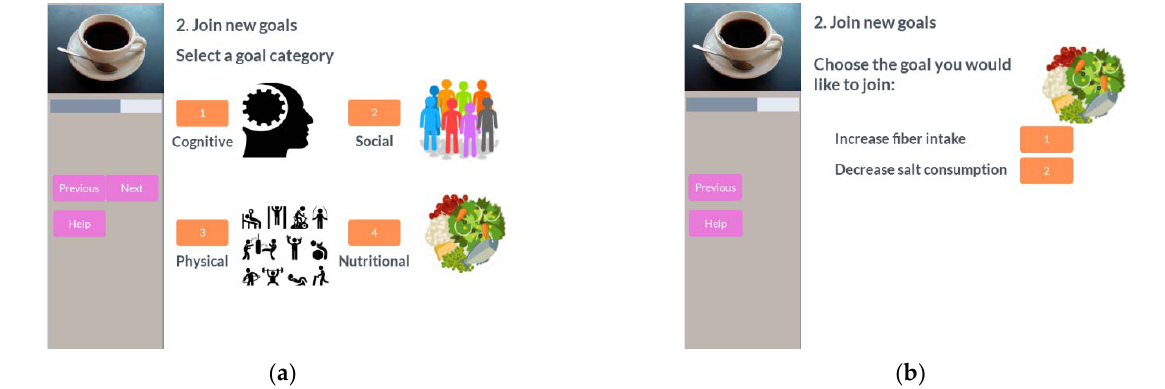
Figure 12. Join goal in coffee session. ( a ) Select goal category; ( b ) select goal in category.